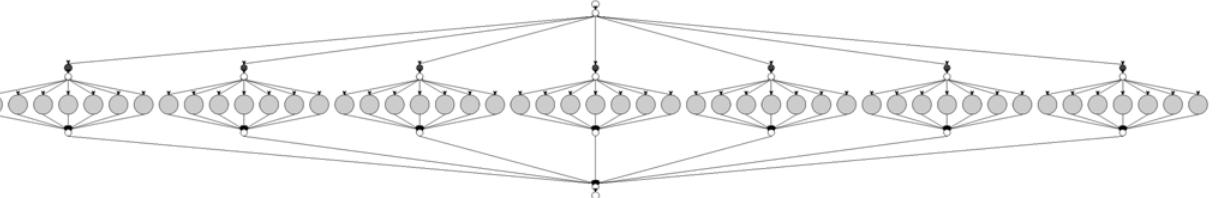
Fig 12. Task graph of BOTS Strassen. Input: dimension = 512, divide and conquer multiplication cutoff = 128, depth cutoff = 1 . Input sizes are reduced to obtain graphs which satisfy space restrictions and preserve clarity.